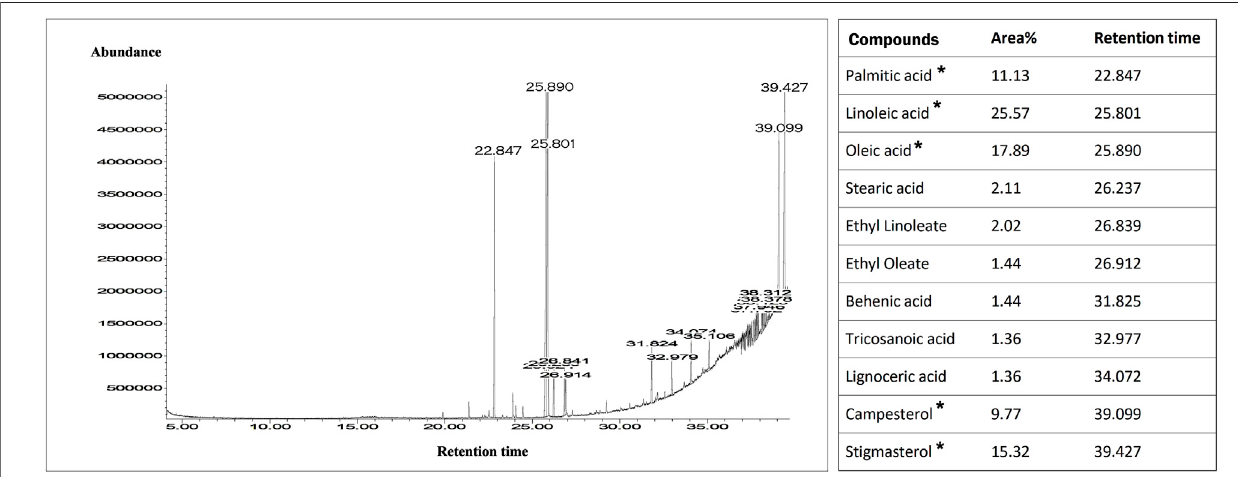
FIGURE 6 | GCMS spectra of the puri fi ed root exudates of Cleome rutidosperma . The list of main compounds with the respective retention times is given in the tableprovided.Thearea%providesinformationabouttheabundanceoftherespectivecompounds.Thecompoundsmarkedwith(*)arethemaincompoundsbasedon the abundance and sharp